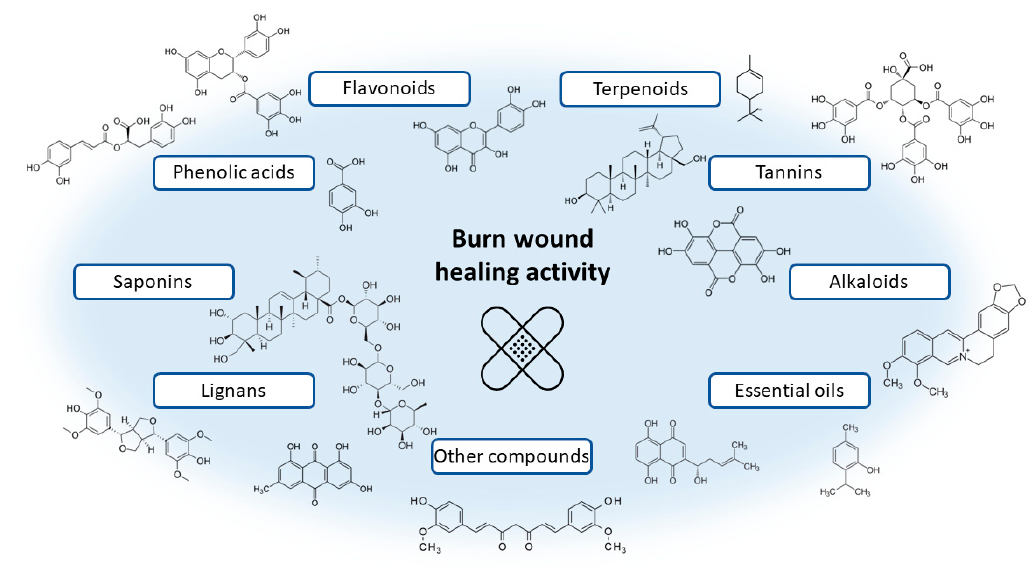
Figure 2. Examples of chemical structures of naturally occurring compounds involved in the wound healing